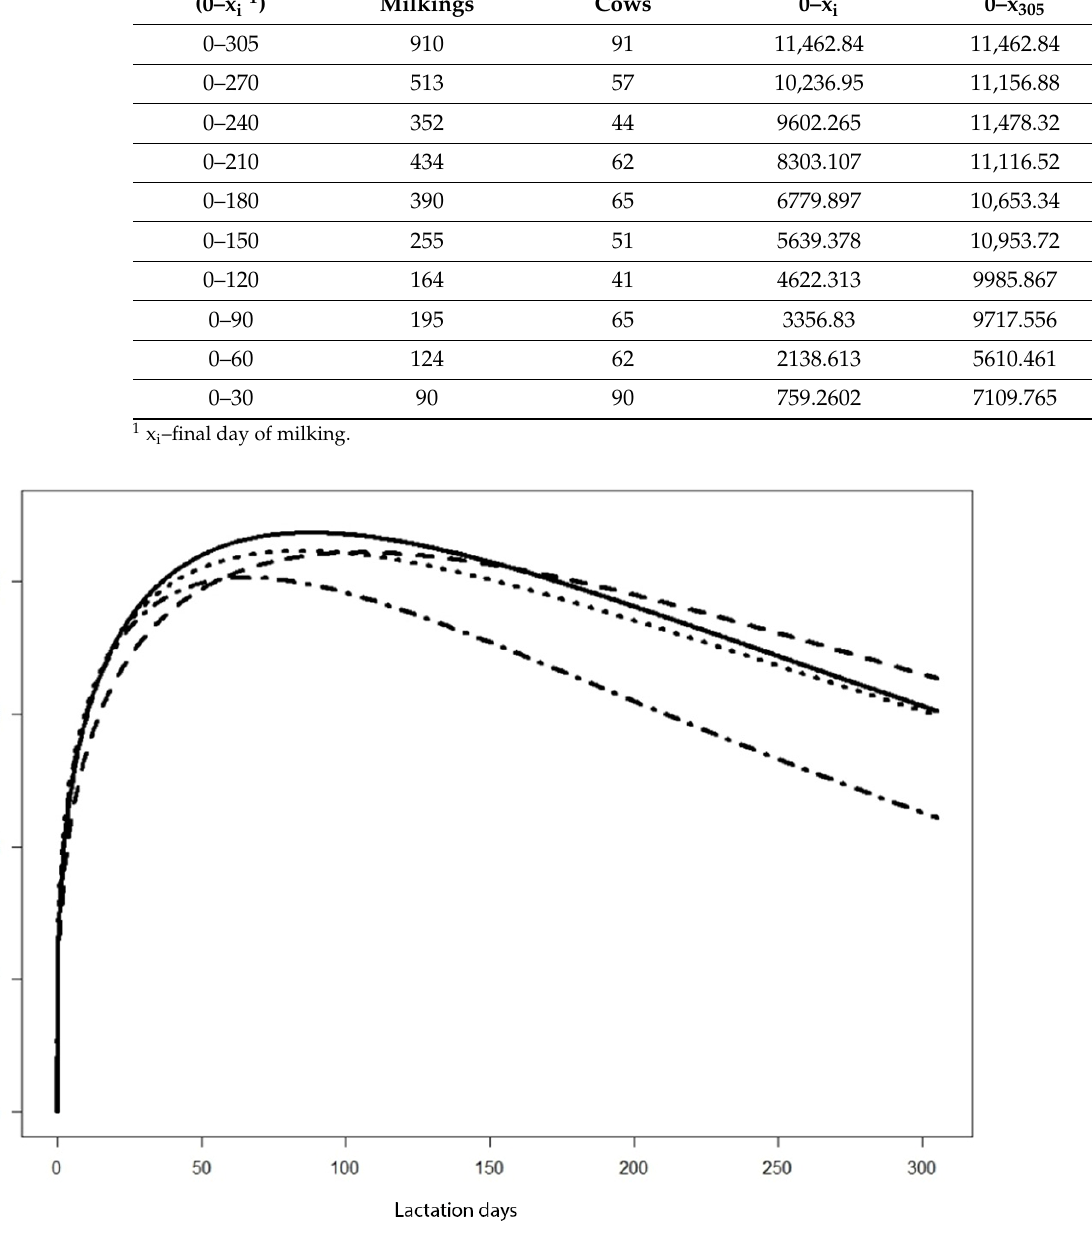
Figure 4. Predicted milk yield curves for culled primiparous cows. Legend: Dashed line—data for all cows milked in herd T1 up to day 305 (including culled cows). Continuous line—data only for cows milked up to day 305. Dotted line—data as for the dashed line, but excluding cows culled up to day 90. Dashed dotted line—data for average values from Figure 3.